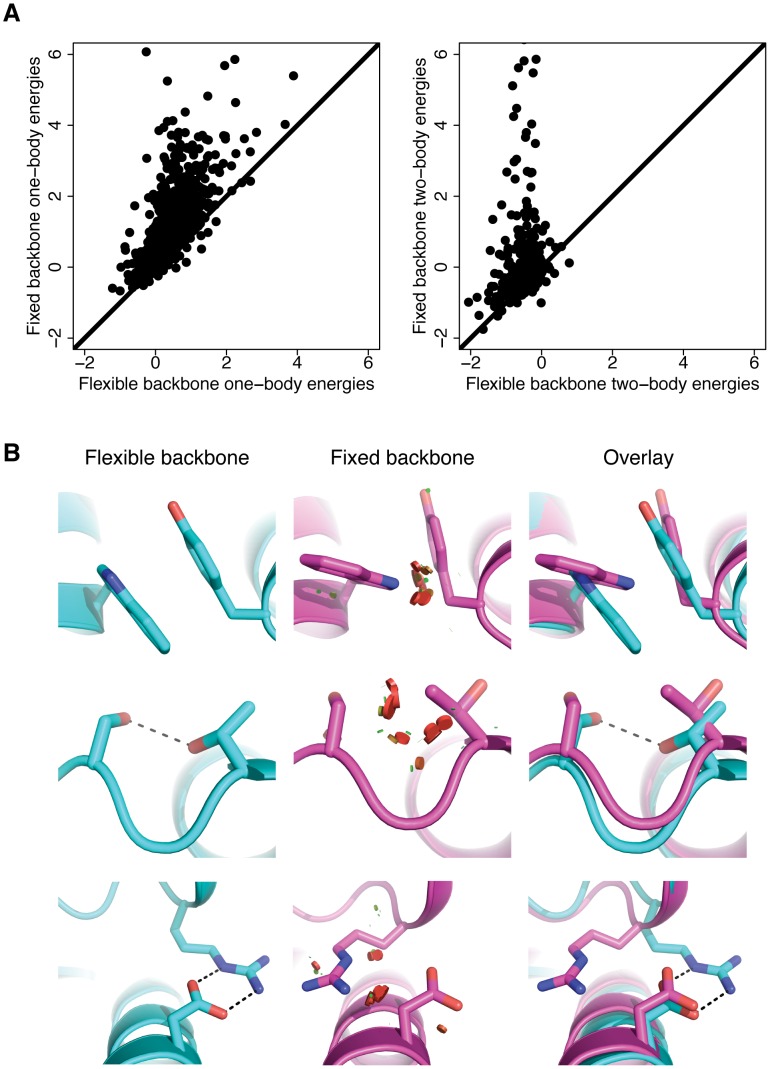
Energetic effects of forcing amino acid covariation onto fixed backbones.A) Scatter plots of covarying pair energies in the context of fixed or flexible backbones. Each dot represents a pair of positions that was found to be highly covarying in the flexible backbone sequences (Backrub, kT = 0.9) and the natural sequences but not in the fixed backbone sequences. Pairs of amino acids at these positions that were found in flexible backbone designs but not in fixed backbone designs were forced onto fixed backbones taken from X-ray crystal structures and their one and two-body energies were calculated. The left plot shows a comparison of one-body energies and the right plot shows a comparison of two-body energies for these pairs. B) Representative examples of pairs of amino acids that require backbone movements to achieve low-energy interactions. Models from flexible backbone design (Backrub, kT = 0.9) are shown in cyan and models from fixed backbone design are shown in magenta. The top case shows a ring stacking interaction, the middle case shows a hydrogen bonding interaction and the bottom case shows a salt bridge interaction. Red disks represent steric clashes, where the radius and number of the disks is proportional to the magnitude of the clash.